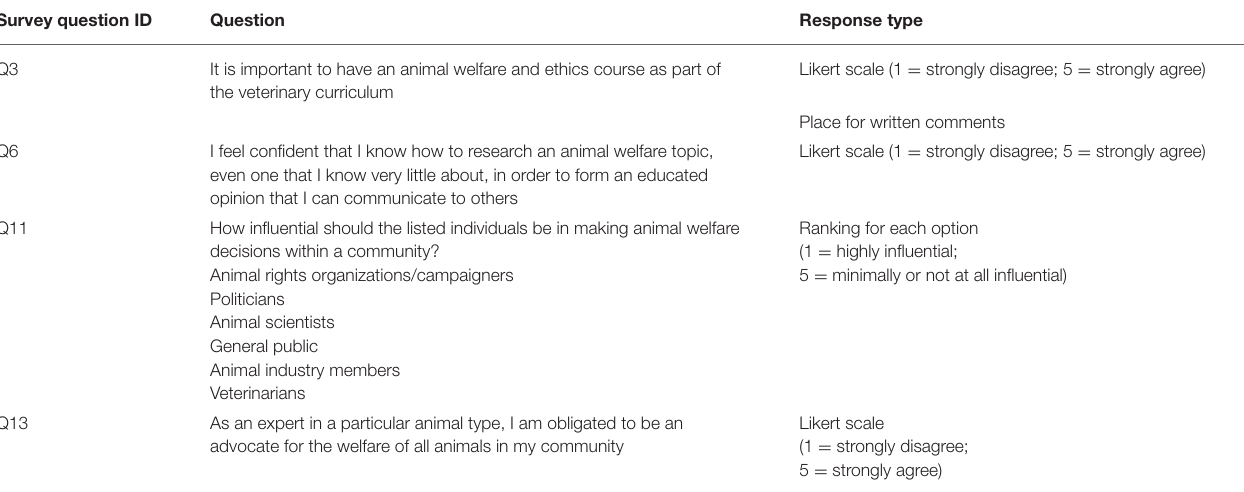
TABLE 2 | Selected survey questions used for analysis focusing on veterinary student attitudes toward animal welfare education and advocacy.